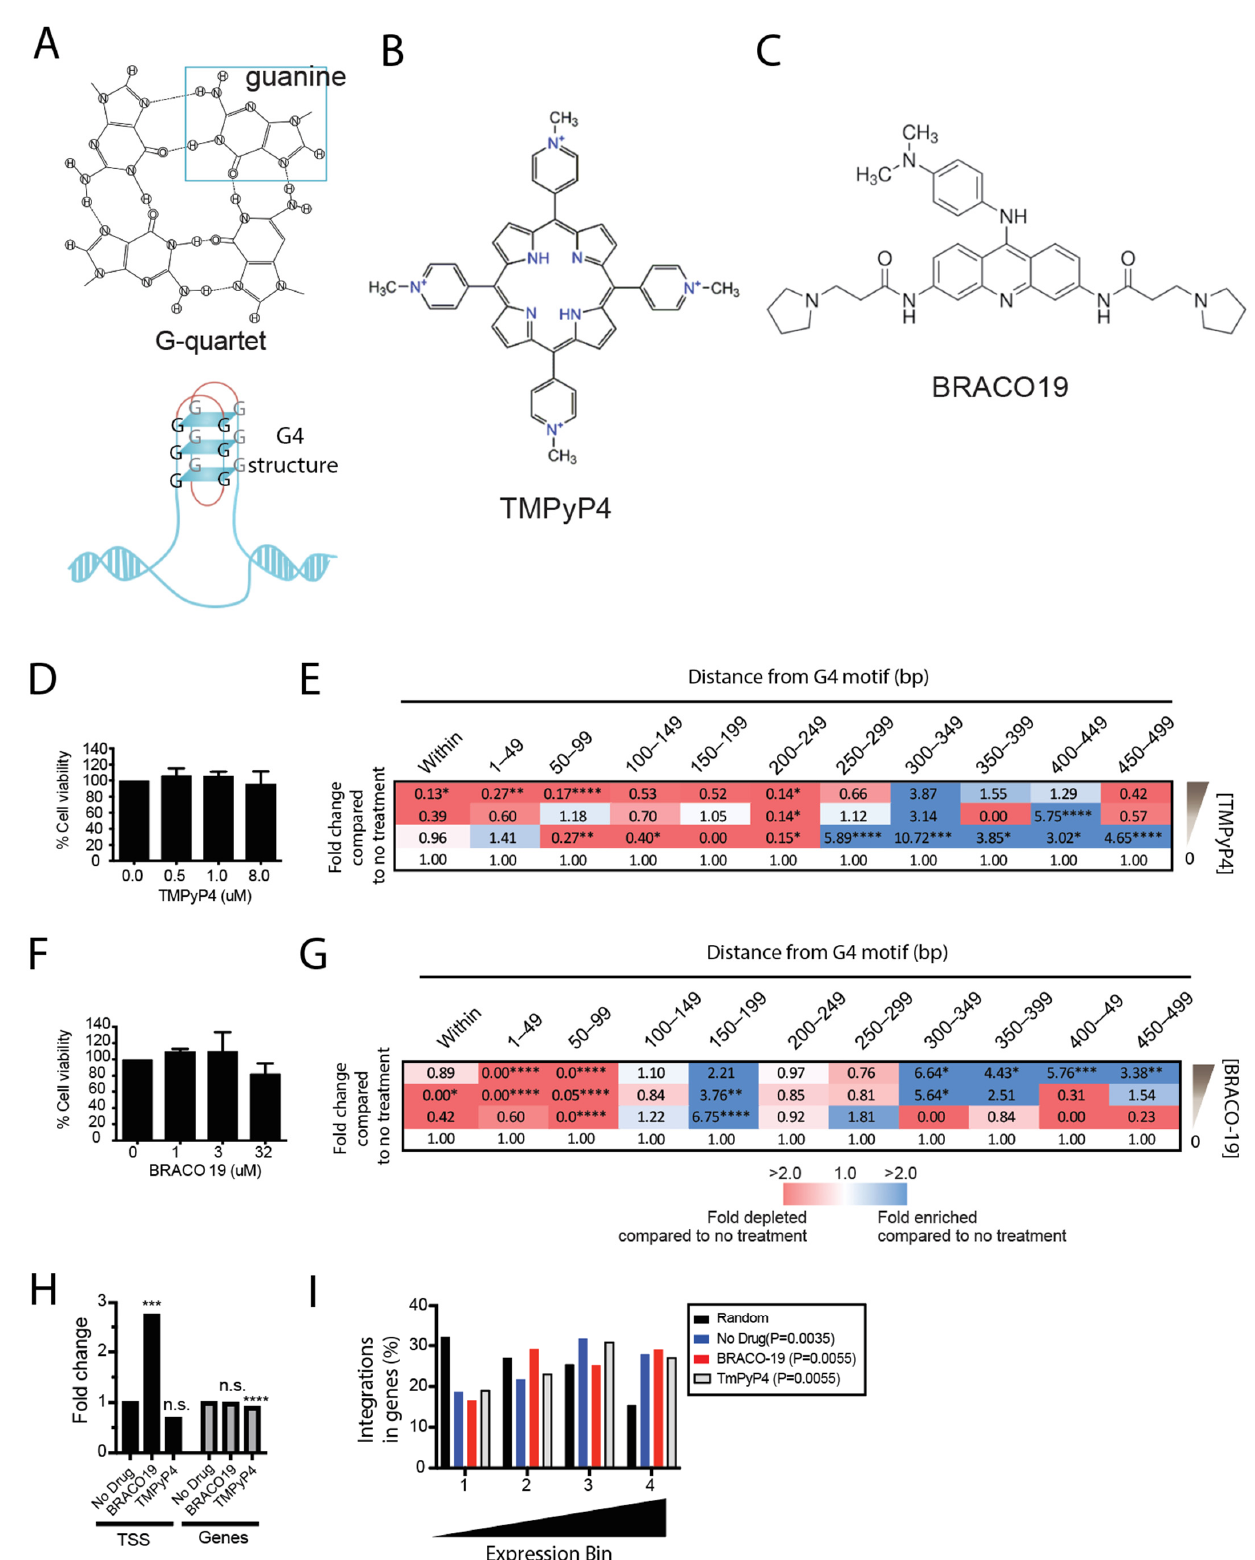
Figure 2. G4 structures influence integration site targeting in the genome. ( A ), Depiction of the nucleoside arrangement of a guanine-quartet and the G4 structure. ( B ), Structure of the TMPyP4 compound. ( C ), Structure of the BRACO-19 compound. ( D ), 293T cells were treated with increasing concentrations of TMPyP4 for 48 h and percent cell viability was determined using the MTT